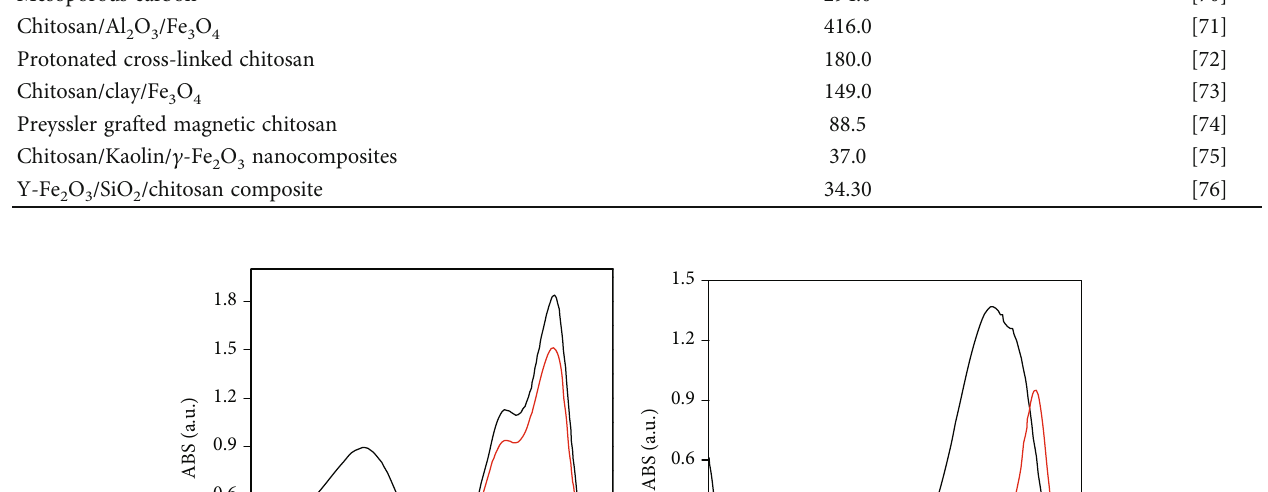
Table 3: Comparison the adsorption capacity of MOF/NH Adsorbent